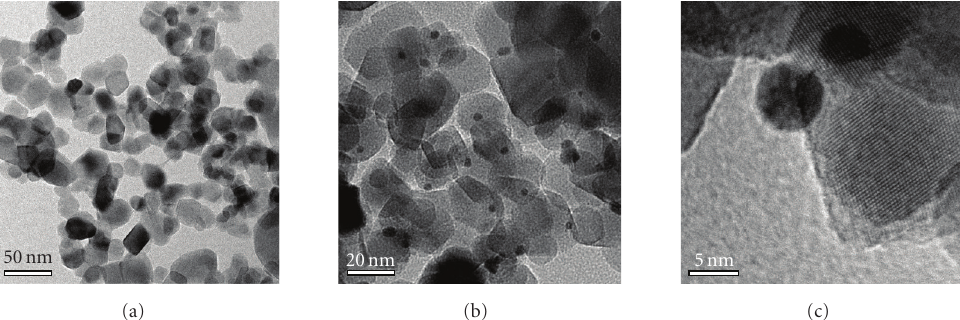
Figure 1: TEM images of TiO 2 nanoparticles (a), and 2wt% Au / TiO 2 prepared by deposition-precipitation method with di ff erent magnifi- cation (b, c). The magnifications of (a), (b), and (c) are 150.000, 40.0000, and 150.0000, respectively.